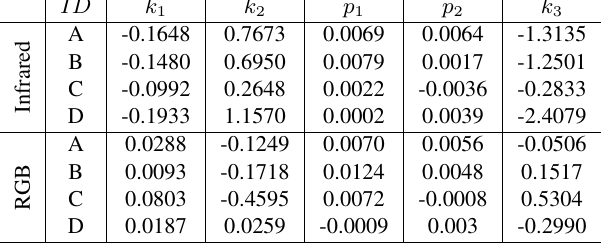
Table 4: Infrared and RGB camera lens distortion parameters (in pixels)